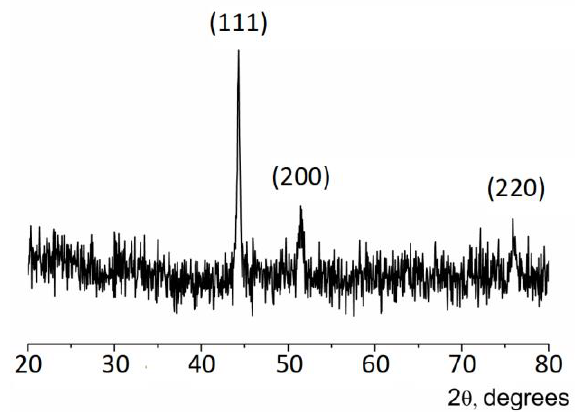
Chemistry 2023 , 5 , FOR PEER REVIEW Figure 2. XRD pattern of Co-Im/SiO 2 composite. Figure 2. XRD pattern of Co-Im/SiO 2 composite.